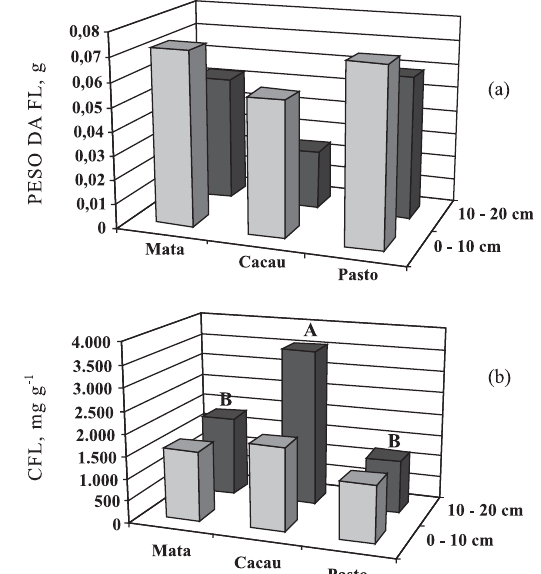
Figura 1. Peso da fração leve da matéria orgânica (a) e teores de carbono na fração leve (CFL) da matéria orgânica (b) em solo de Mata Atlântica submetido a diferentes usos, nas profundidades de 0–10 e 10–20 cm. As médias das variáveis não diferem estatisticamente entre os usos